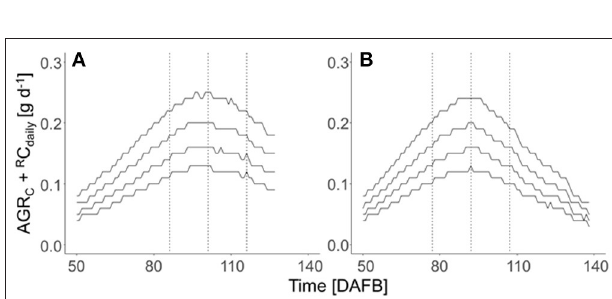
FIGURE 2 | Seasonal course of the sum of the C-based daily fruit growth rate (AGR C , g d − 1 ) and daily respired C per fruit ( R C daily , g d − 1 ) of ‘Gala’/M.9 apples with target diameters of 65, 70, 75, and 80mm (from the bottom to